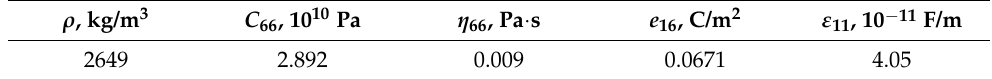
Table 2. The obtained values of the quartz resonator material constants.